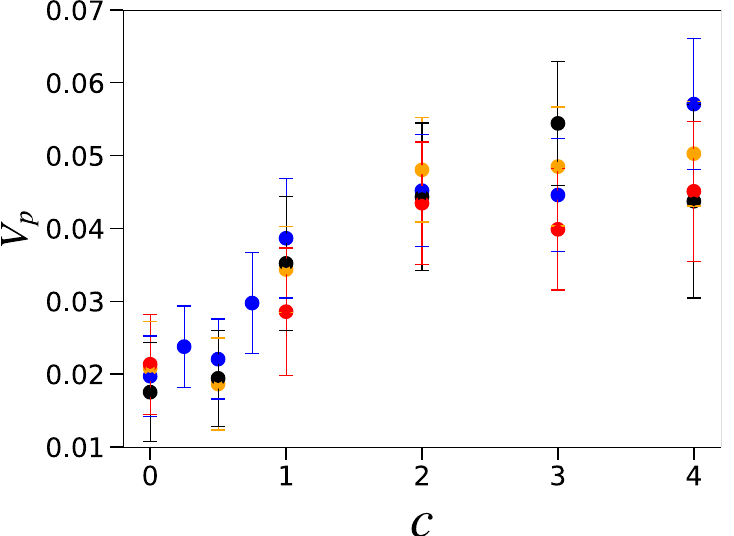
Fig 2. Total phenotypic variance V p of the output genes against the parasite interaction strength. The variance V p of the output genes plotted against the parasite interaction strength c (bars represent standard deviation). V computed from the expression levels of the output genes over the host population ( N = 300 individuals) and plotted as the average V over 2500–3000 generations. Each color represents a different noise strength: σ = 0.03 (blue), 0.02 p (orange), 0.01 (black), and 0.001 (red).